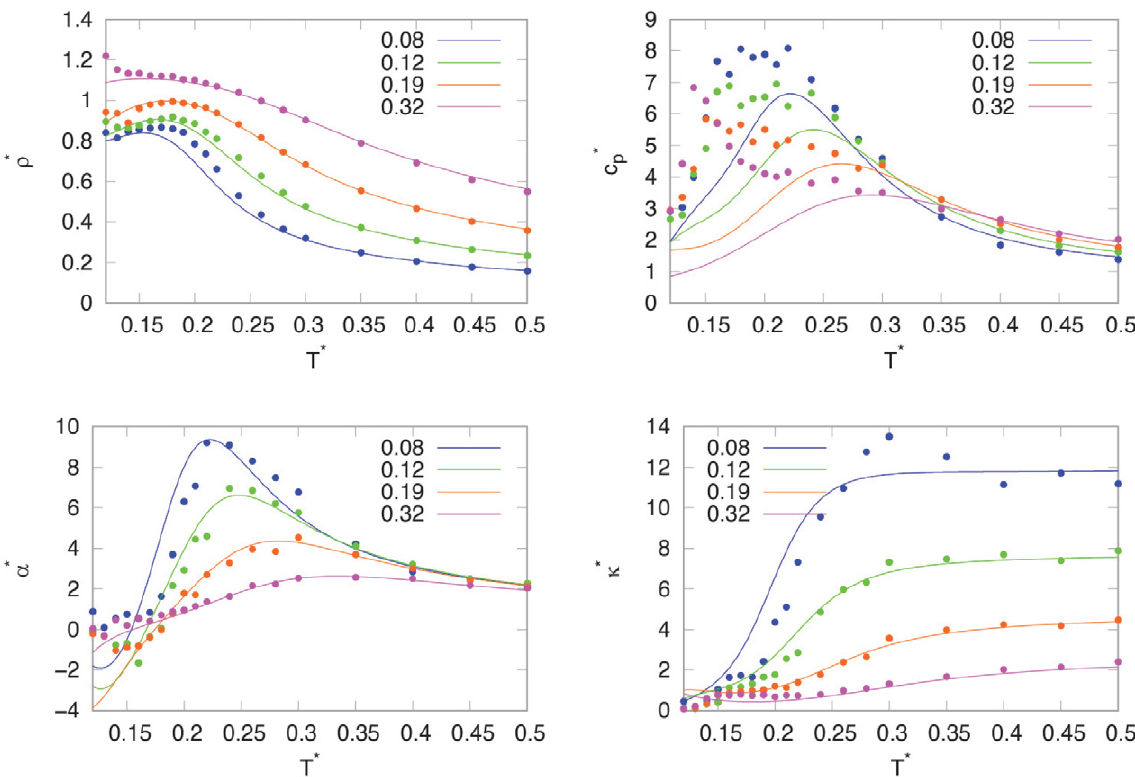
Figure 7: Temperature dependence of the density ( ρ * ), heat capacity ( c p* ), thermal expansion coefficient ( α * ), and isothermal compressibility ( κ * ) for 2D MB water for different pressures. Results from the theory are plotted with lines and from the computer simulations 40 by